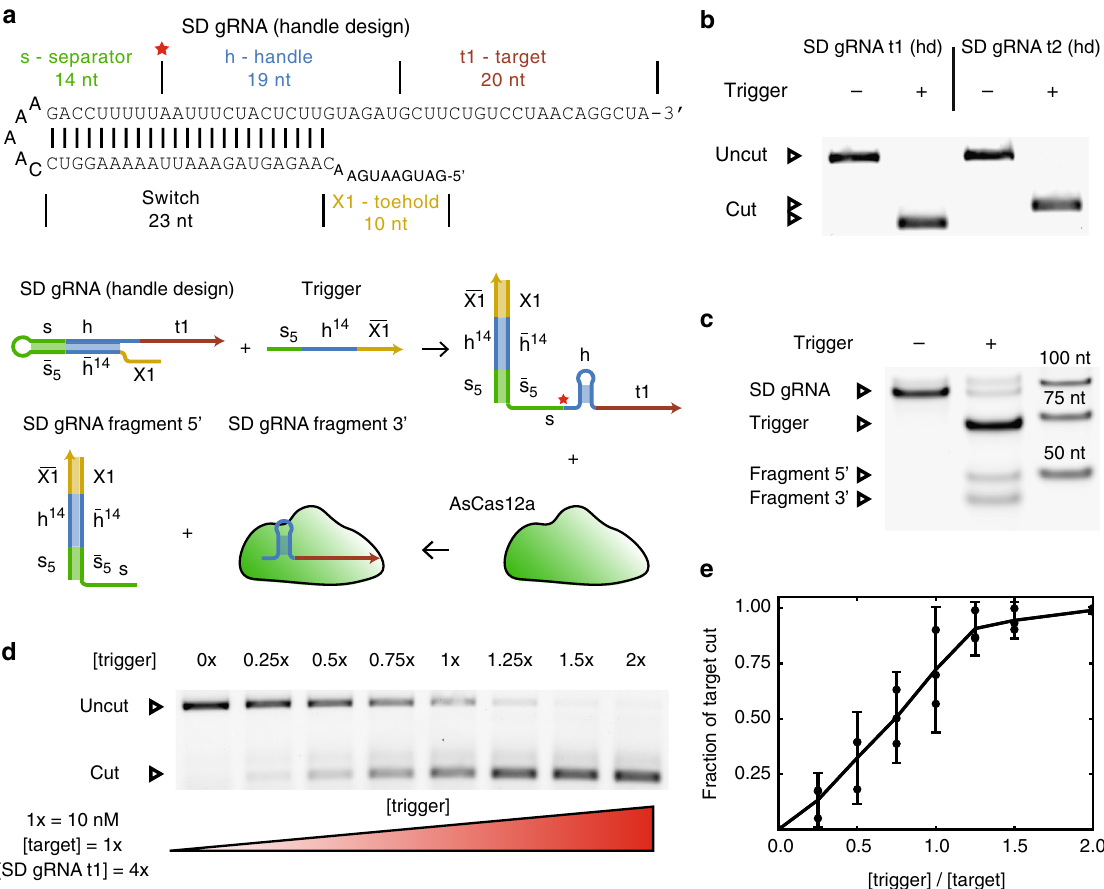
Fig. 2 Principle of strand displacement switchable gRNAs. a When the RNA trigger binds the SD gRNA, the 5 ′ extension domain occluding handle is displaced, thereby restoring the gRNA handle. Binding of Cas12a leads to cleavage of the gRNA, which removes the 5 ′ extension and creates an active Cas12a-gRNA complex. The domains are labeled as follows: s — separator, h — handle, t — target, X1 — toehold. The overall nomenclature follows Zhang et al. 32 : A domain is denoted by a single letter. An upper index x denotes the fi rst x nucleotides of a domain counting from its 5 ′ end. A lower index x denotes all but the fi rst x nucleotides of a domain counting from its 5 ′ end. A combination of upper and lower indices includes those nucleotides that are present in both subdomains. A bar above the letter marks the reverse complement of a domain. The red star marks the position where Cas12a cleaves a successfully bound gRNA. b Agarose gel showing cutting of a target DNA by handle-based SD gRNAs with two different target sequences in the absence and presence of trigger RNA (uncut: 1190 bp, cut t1: 357 bp, cut t2: 506 bp). c Denaturing PAGE showing induced gRNA processing due to trigger binding. d Agarose gel showing activation of target cutting by varying amounts of trigger RNA (uncut: 1190 bp, cut: 357 bp). e Transfer function derived from the fraction of cut target by gels as shown in ( d ) ( N = 3, t -distribution two-sided 90% con fi dence interval). Source data are provided as a Source Data fi